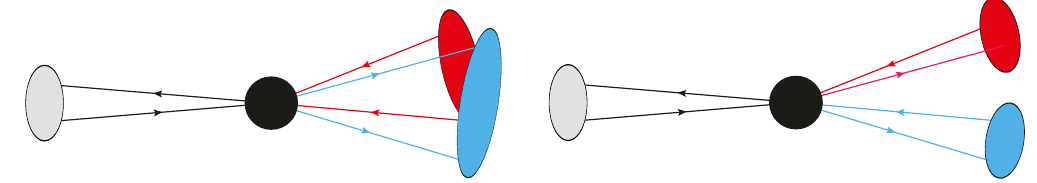
Figure 14 . Sketch of a con(cid:12)guration where the two coloured clusters could be viewed as an independently evolving subsystem. Gluon exchanges which would lead to colour connections with the grey cluster are expected to be highly suppressed. Left: initial colour (cid:13)ow. Right: colour (cid:13)ow after